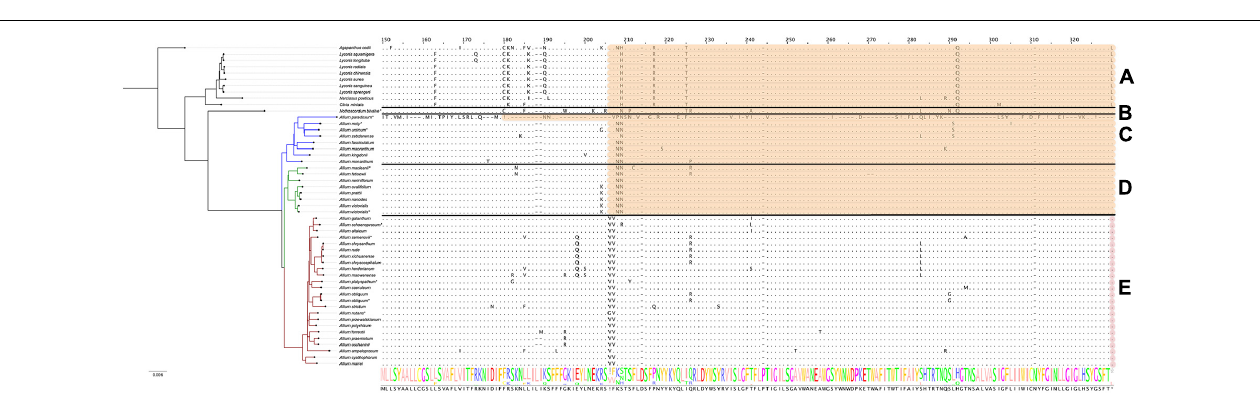
FIGURE 5 | Protein sequence alignment of the cytochrome c biogenesis protein encoded by ccsA genes. Àll species are sorted by phylogenetic tree: the first evolutionary line of Allium is blue, the second is green, the third is red and the remaining species are black. Species sequenced by our group are marked with *. (A) Shows Agapanthoideae and Amaryllidoideae subfamily species; (B) shows Nothoscordum bivalve as an outgroup for Allium genus; (C) shows the first evolutionary line Allium species; (D) —the second and (E) —the third. Alignment here starts from the 150th AA position for better visualization. Non-conserved AA positions are highlighted as letters and conserved as dots. The whole AA sequence is shown as a normalized alignment logo below. Possible frameshifts are shown as ! and stop codons as *. Damaged sequences are highlighted in peach color in case of frameshift and in purple in case of stop codon. Colored sequences may be assumed to be a